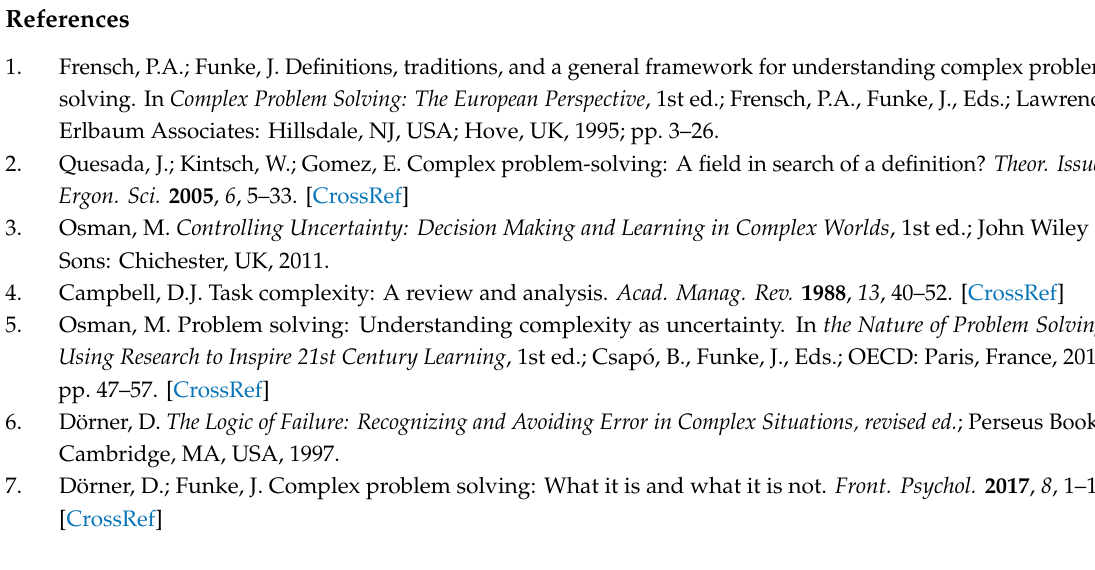
Intuitive Ability Intuitive Engagement − 0.076